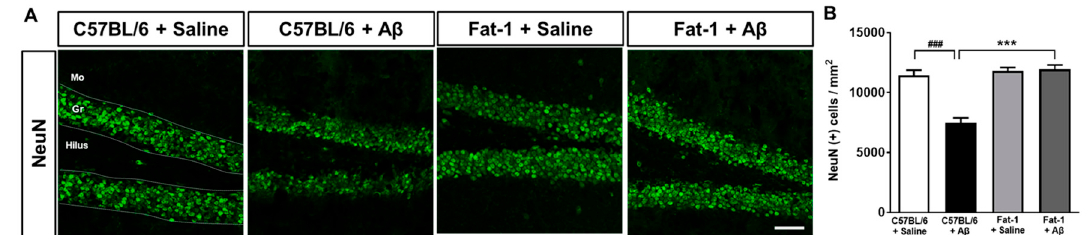
Figure 2. Neuroprotective effects of endogenous elevation of omega-3 PUFAs on neuronal loss demonstrated following A β -stereotaxic injection in fat-1 mice. ( A ) Immunofluorescent staining was performed with the neuronal marker (neuronal nuclei) NeuN in the DG (scale bar = 50 μ m). ( B ) The number of NeuN-stained cells per area in the granular cell layer of the DG was significantly increased in fat-1 + A β mice compared to the number observed in C57BL / 6 + A β mice. Data are presented as mean ± SEM (30–36 images / 5–6 mice). ### p < 0.001: C57BL / 6 + Saline versus C57BL / 6 + A β . *** p < 0.001: C57BL / 6 + A β versus Fat-1 + A β . Gr: granular layer, Mo: molecular